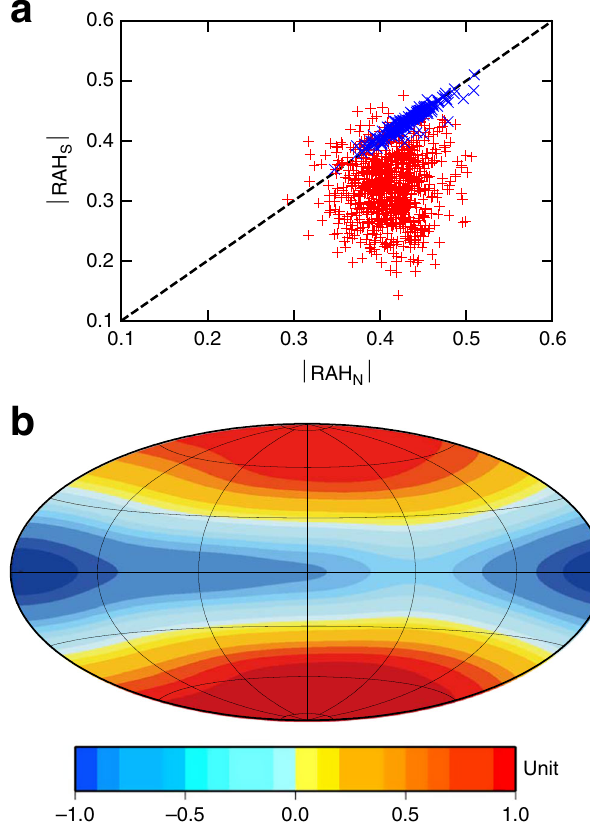
Fig. 4 Effects of symmetry-breaking feedback of the magnetic fi eld on convection to yield hemispherical bias in RAH and the offset dipolar fi eld. a Plot of the absolute values of RAH in the northern hemisphere, |RAH N |, vs. those in the southern hemisphere, |RAH S |, in BU1 (red) and the corresponding kinematic run BU1K (blue), where the Lorentz force is removed from the momentum equation. Symbols represent those values at different times. When convection is perfectly symmetric with respect to the equator, |RAH N | and |RAH S | lie on the dashed line with a slope of unity as in the kinematic run. b Snapshot of the normalized radial magnetic fi eld distribution at the planetary surface in the run BU1K. Unit is normalized by the maximum value, since the case is